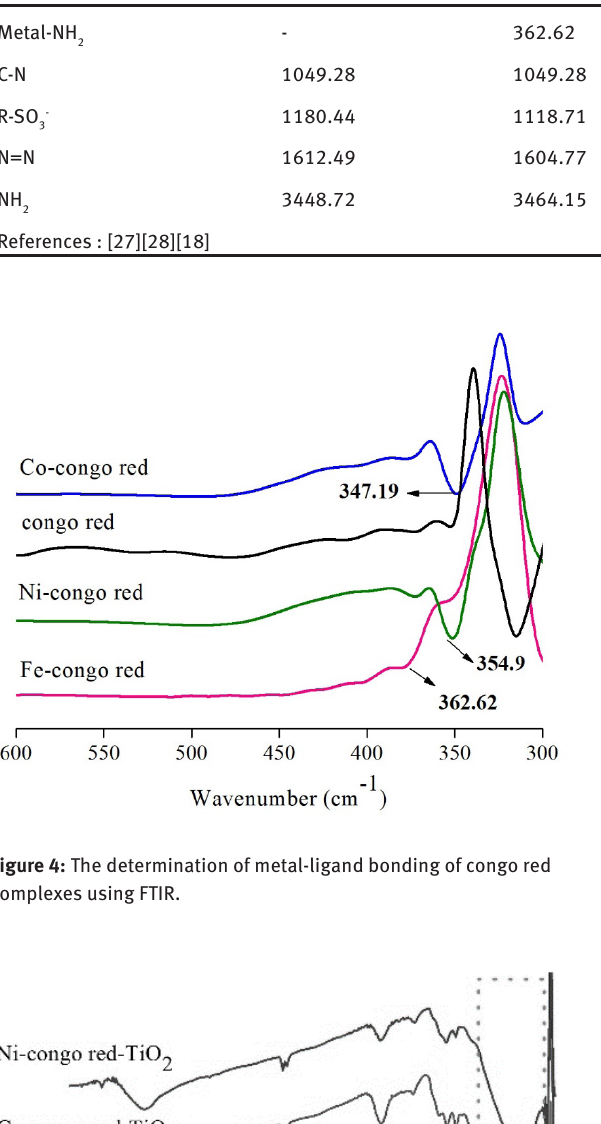
Figure 5: The determination of TiO complexes using FTIR